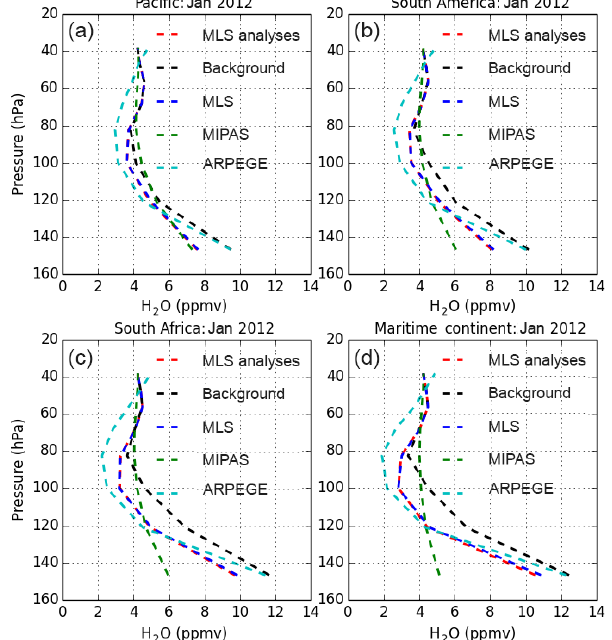
Figure 6. Monthly averaged vertical profiles of H 2 O in January 2012 in the MLS observation space from MLS analyses (red dashed line), background (black dashed line), MLS (blue dashed line), MI- PAS (green dashed line) and ARPEGE (light blue line) in four dif- ferent tropical areas (see Fig. 1): Pacific Ocean (a) , South Amer- ica (b) , South Africa (c) and the Maritime Continent (d) .